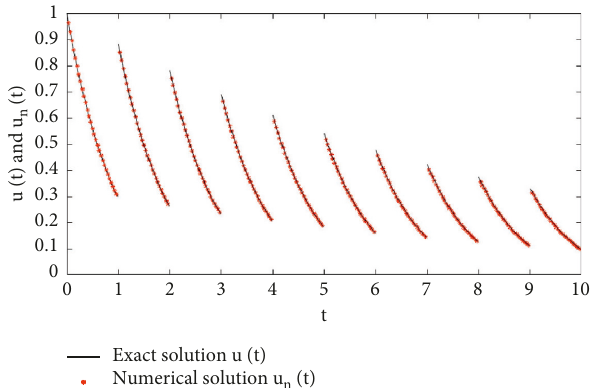
Figure 1: Comparisons of the results of Example 1 ( n � 30 ) .